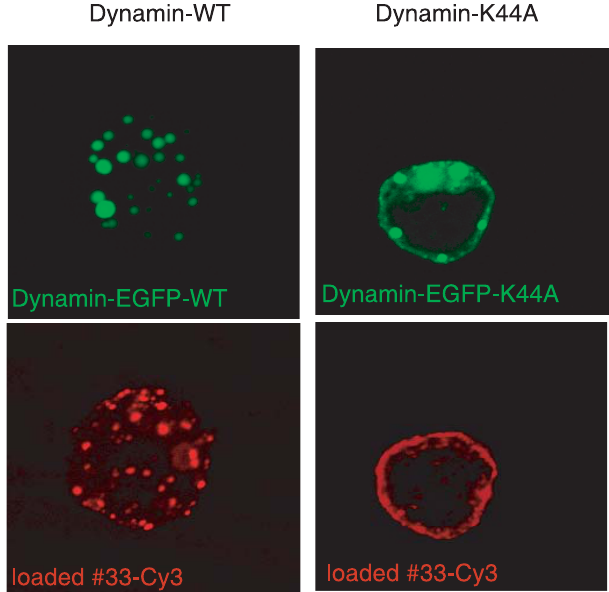
Figure 3. Internalization of KIR2DL4 Is Dynamin Dependent The 293T cells transfected with HA-tagged KIR2DL4 together with either wild-type dynamin-gfp (Dynamin Egfp-WT) or a dominant-negative mutant of dynamin (dynamin Egfp-K44A) were loaded with KIR2DL4- specific Cy3-conjugated mAb 33 for 120 min and fixed. Individual confocal sections are shown. DOI: 10.1371/journal.pbio.0040009.g003 Figure 4. Immunolocalization of Endocytosed KIR2DL4 in NK Cells by